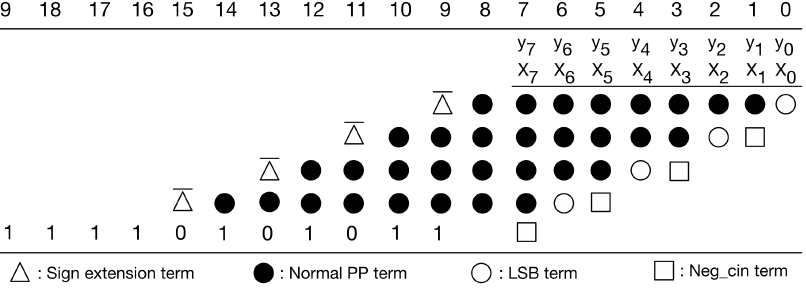
Figure 11. Our simplified PPM with guard bits.